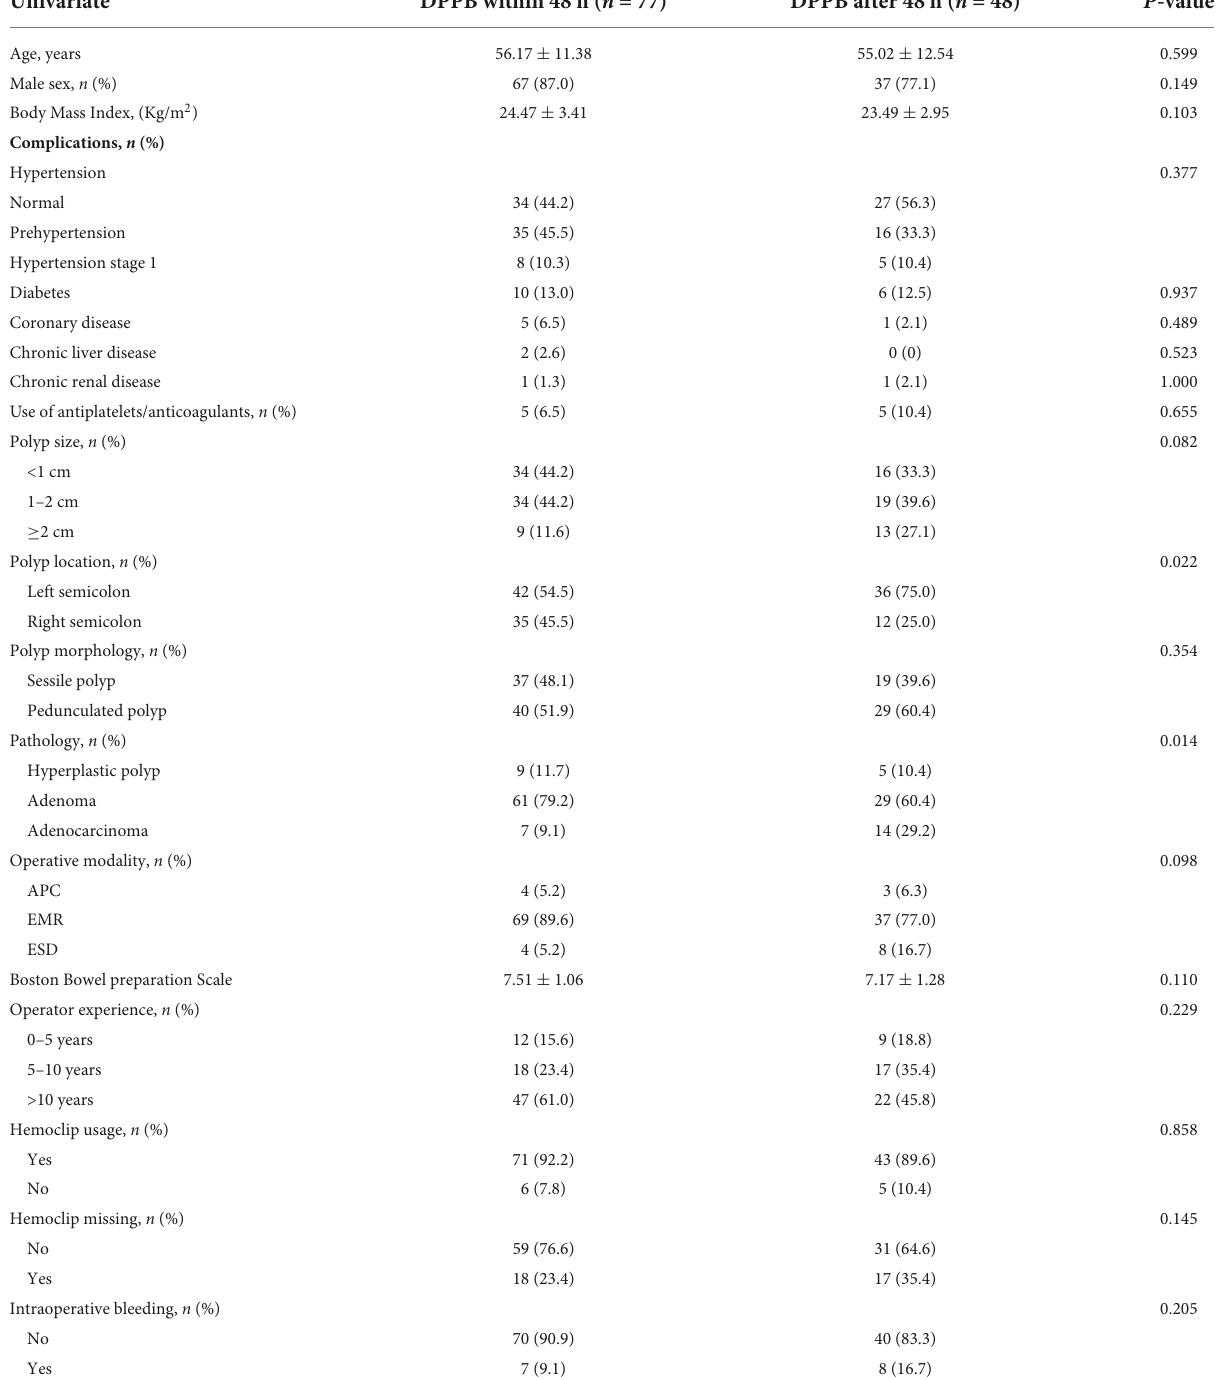
TABLE 5 Univariable analysis and multivariable logistic analysis for factors associated with delayed post-polypectomy bleeding after 48 h.